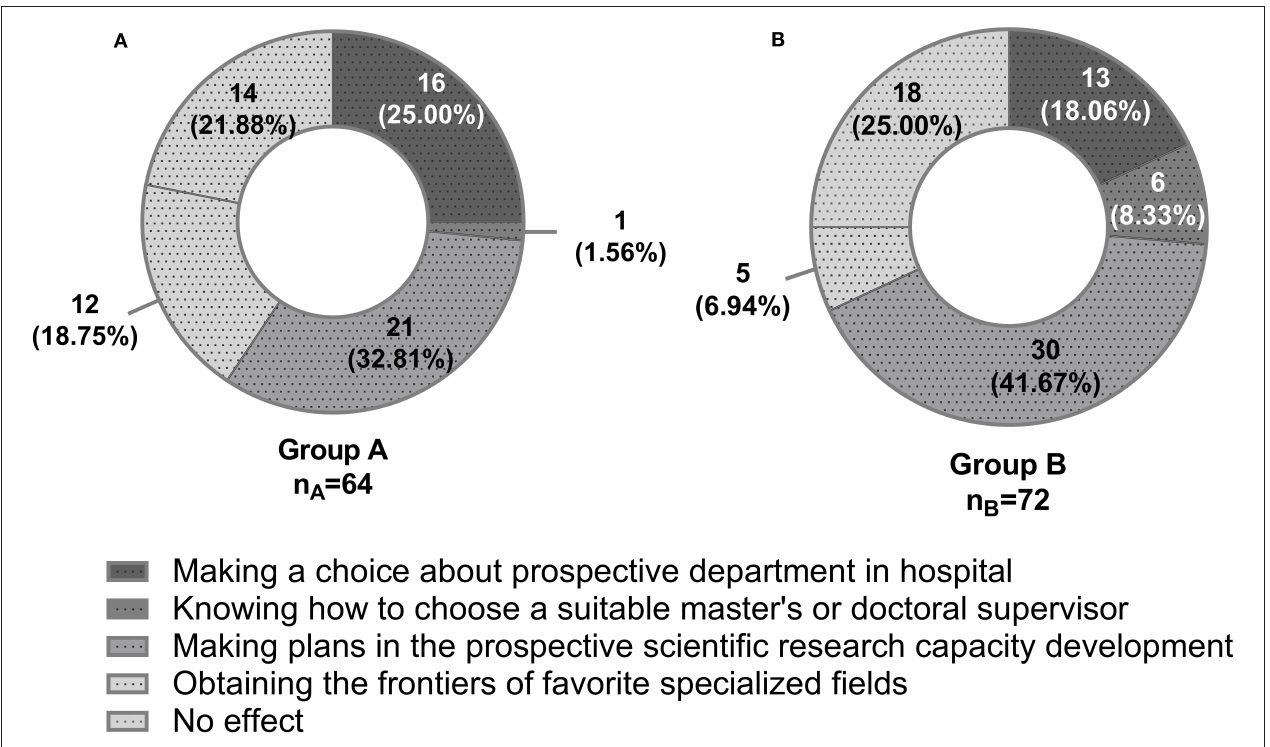
FIGURE 1 | The greatest effect of the undergraduate tutor system on students. (A) Group A, single tutor for multiple students’ system. (B) Group B, multiple tutors for multiple students’ system. The chi-square test was applied for the